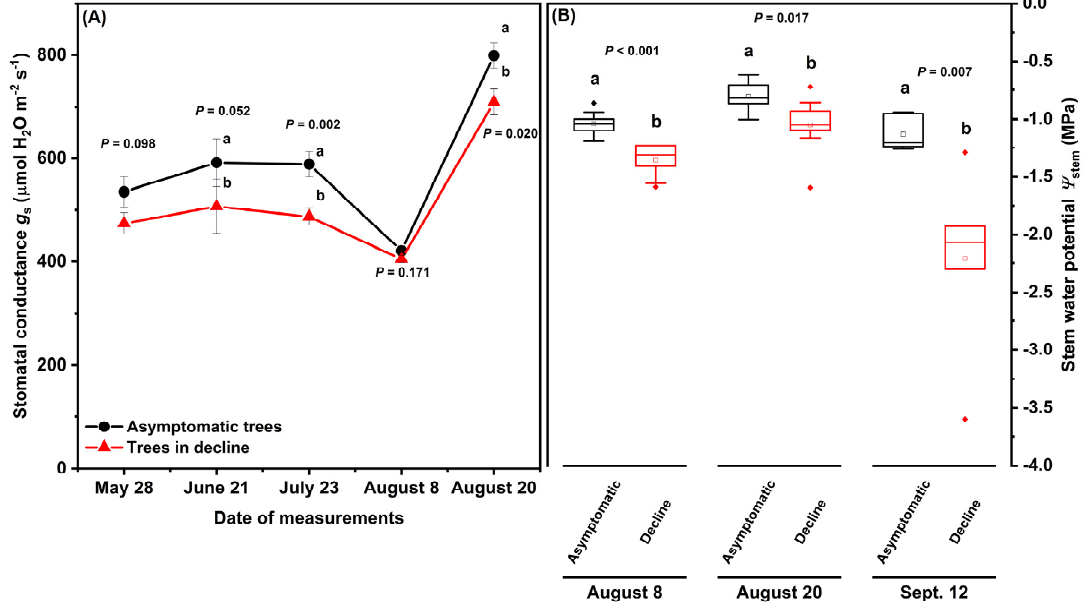
Figure 2. Stomatal conductance g s ( A ) and mid-day stem water potential Ψ stem ( B ) of asymptomatic and declining ‘Ambrosia’/M.9 apple trees at Site S in the growing season of 2019. Different letters stand for significant difference at p = 0.05 between asymptomatic and declining trees on each date ( n = 6; p values from one-way ANOVA with tree heath status as the fixed effect are noted for each pair of comparison, Tukey’s test). In ( A ), dots with error bars are means ± standard errors. In ( B ), horizontal lines show median and interquartile ranges, dots show outliners and squares stand for mean.